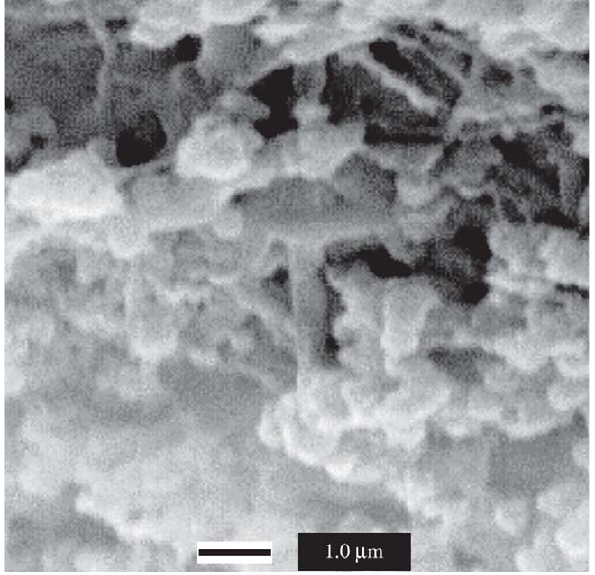
Figure 2. Collagen sample chemically treated with TEOS for 1h and immersed in SBF solution for 10 days.